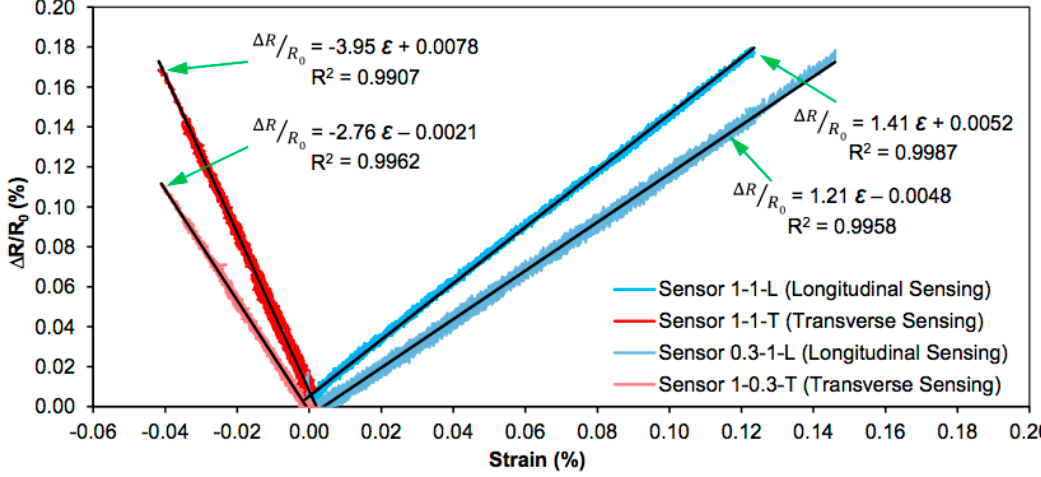
Figure 3. Experimental results obtained from the former specimen. The abscissa axis shows the longitudinal or transverse strain measured experimentally with a biaxial strain gauge (from reference [16], with permission from CC4).